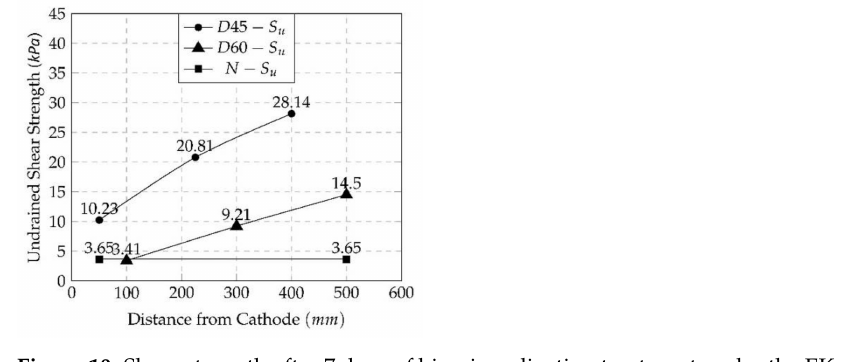
Figure 10. Shear strength after 7 days of biomineralization treatment under the EK method for D45 and